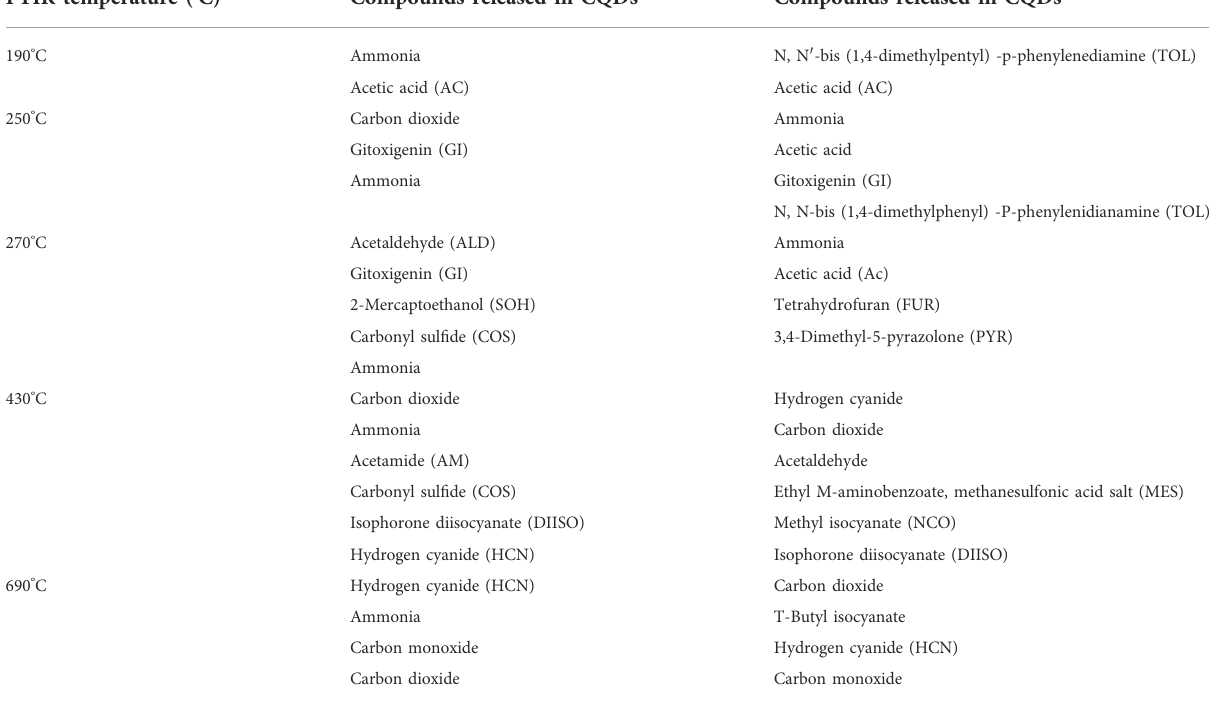
TABLE 1 Evolved gases observed during the thermal decomposition of CQDs a and CQDs b